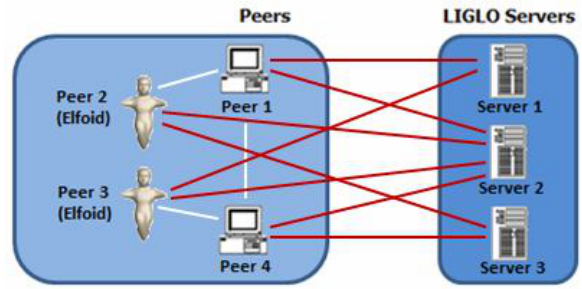
Figure 3. Network topology of peers and